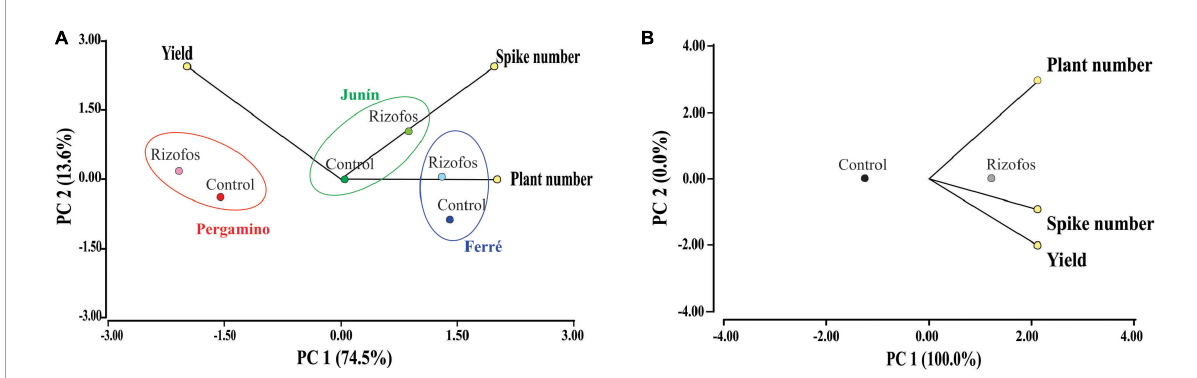
FIGURE2 Agronomic efficiency of Pseudomonas sp. strain 1008. Principal component analyses of wheat parameters measured for 25 field assays (for details, see Supplementary Table 2 ). Data were partitioned by seed bacterization treatment with Pseudomonas sp. strain 1008, and by location (A) ; or, only by seed bacterization treatment (B) . (A) In each location, wheat grain yield and the number of spikes per m 2 mainly explain the seed bacterization effect. Together, PC1 and PC2 explain > 85% of the total variance. PC1 explains the geographical effect, whereas PC2 explains the bacterization effect for each geographical site. (B) Seed bacterization clearly influenced the three measured variables, explaining the whole variance. In both plots, “Rizofos” refers to the seed bacterization